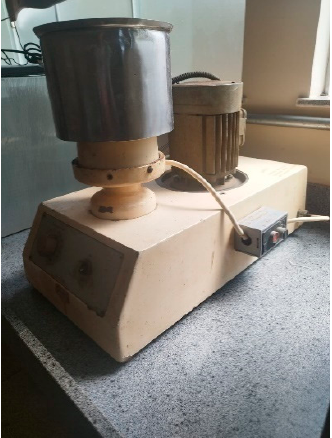
Figure 2. Knife mill utilized for grinding WEEE plastic to adequate particle size to be fed into the pyrolyzer.